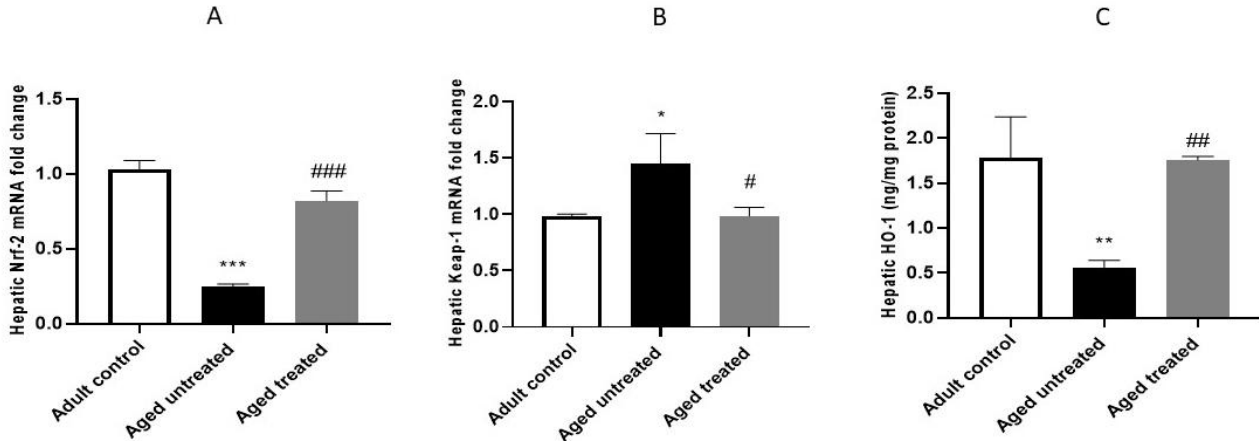
Figure 4. Effect of VK2 administration on the Keap-1/Nrf-2/HO-1 axis in hepatic tissues. ( A ) Hepatic Nrf-2, ( B ) hepatic Keap-1 mRNA fold change, as detected by RT-PCR and ( C ) hepatic HO-1 concentration (ng/mg protein) as detected by ELISA. Values are expressed as the mean ± SE, n = 6. * p < 0.05, ** p < 0.01 and *** p < 0.001 compared to the Adult control group. # p < 0.05, ## p < 0.01 and ### p < 0.001 compared to the Aged untreated group.